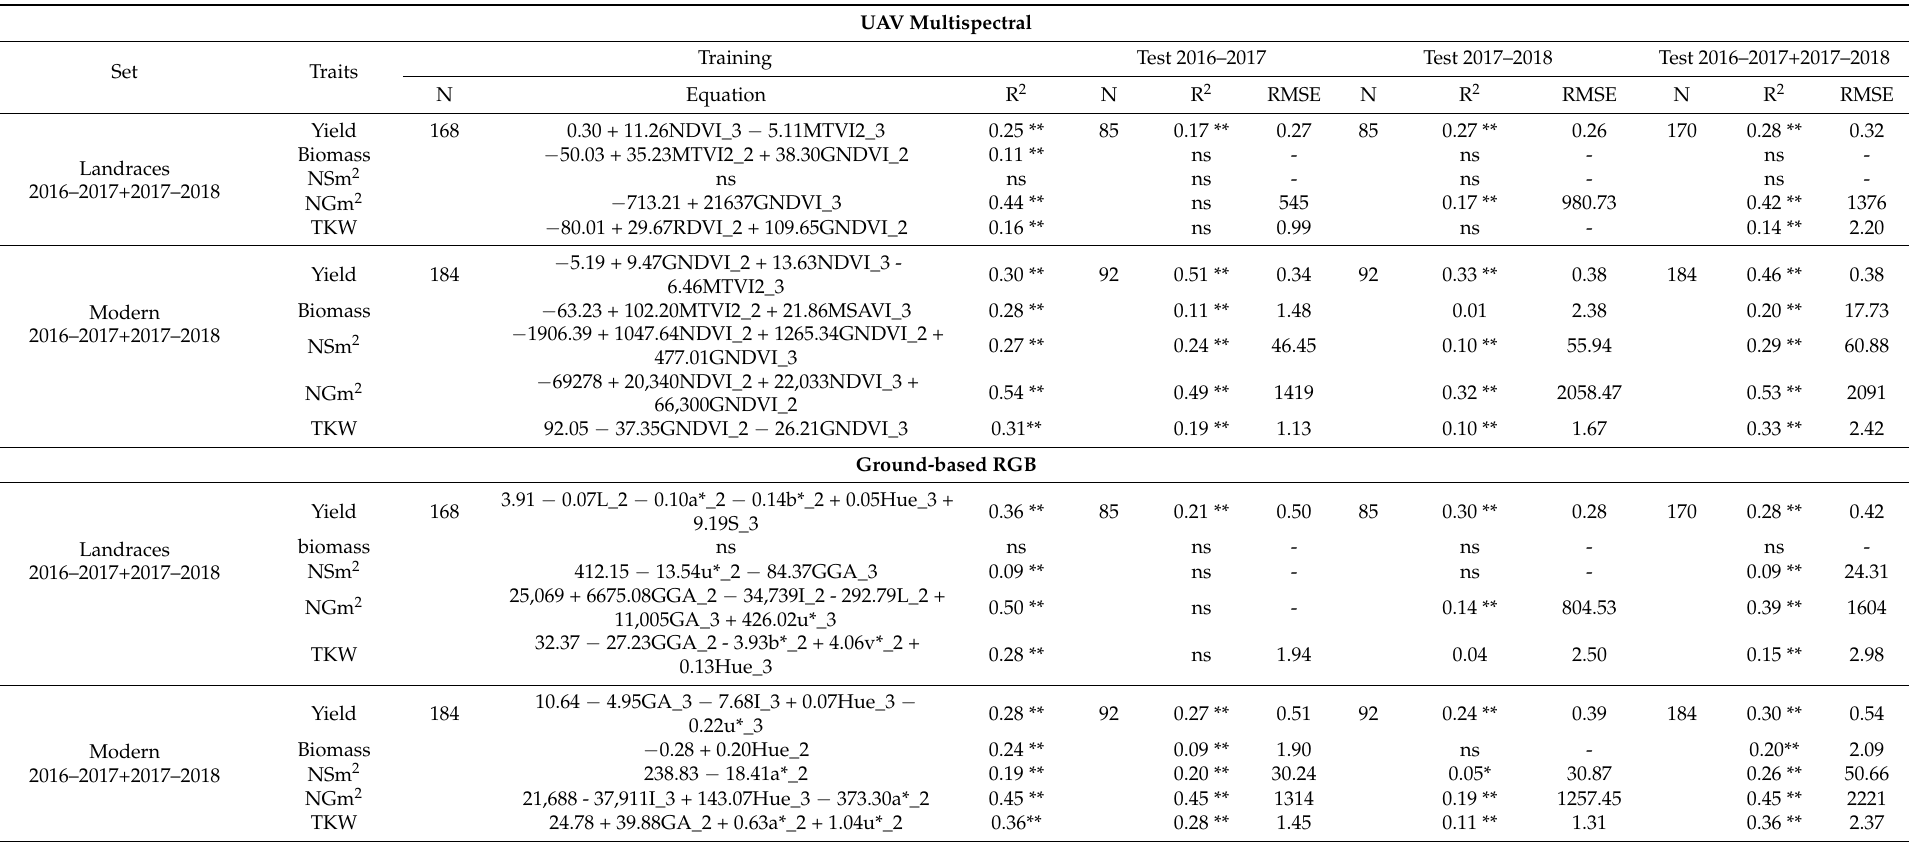
Table 8. Training and Test statistics of the models for the estimations of agronomic traits through UAV multispectral and RGB VIs aggregating the data of the two growing seasons for landraces and modern cultivars. * p < 0.05. ** p < 0.01. N, number of genotypes; R 2 , determination coefficient; RMSE, root mean standard error; Yield (t/ha); NSm 2 , number of spikes per square meter; NGm 2 , number of grains per square meter; TKW, thousand kernel weight (g); I, intensity; L, lightness; S, saturation. Number after each VI means the flight occasion: 1, 128 DAS; 2, 151-153 DAS; 3, 179-184